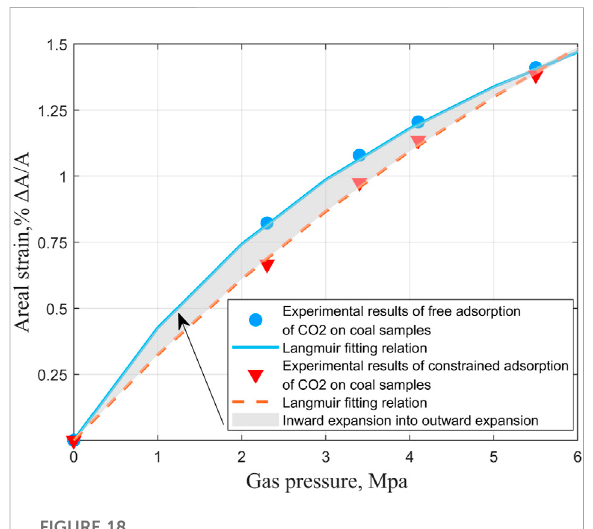
FIGURE 18 CO 2 experimental results of free adsorption and constrained adsorption of coal samples under different gas pressures and comparison of fi tting